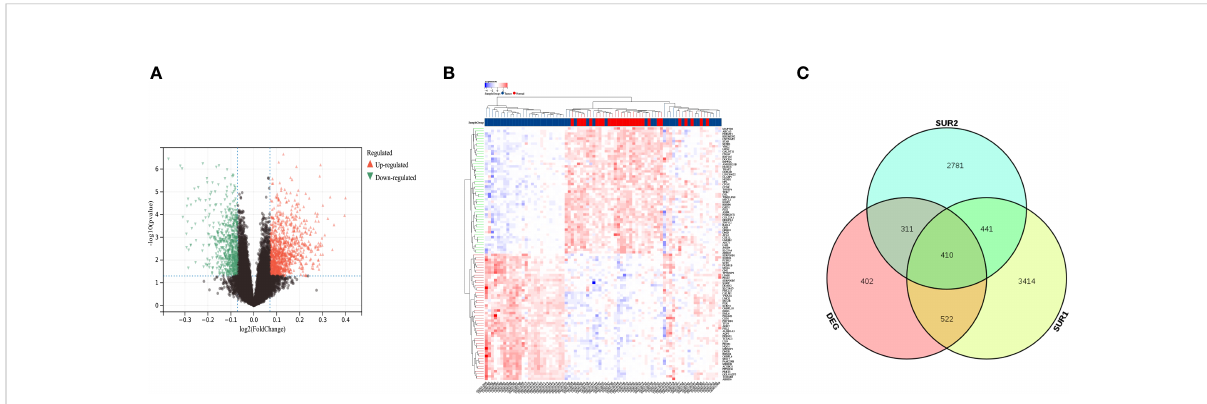
FIGURE 2 Identi fi cation of differentially expressed mRNAs and lncRNAs. (A) Volcano map showing differentially expressed lncRNA and mRNA; (B) Heat map showing differentially expressed lncRNA and mRNA; (C) Venn diagram screening SUR1, SUR2 module genes and overlapping genes of differential